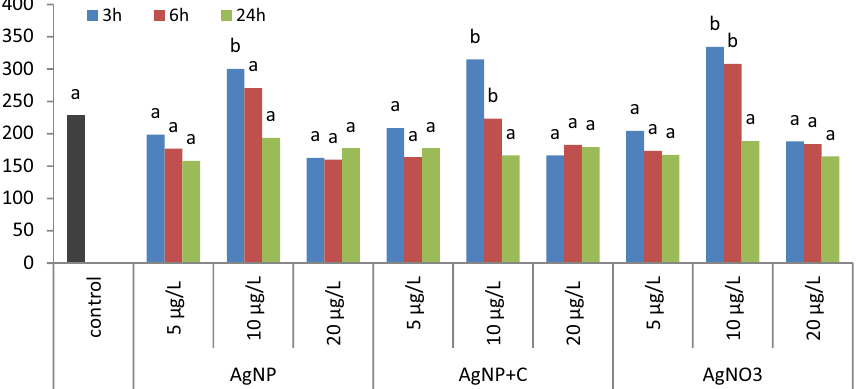
Figure 3. Mean cell damage level as TM values for the controls and tested samples at different concentrations after 3, 6 and 24 h.